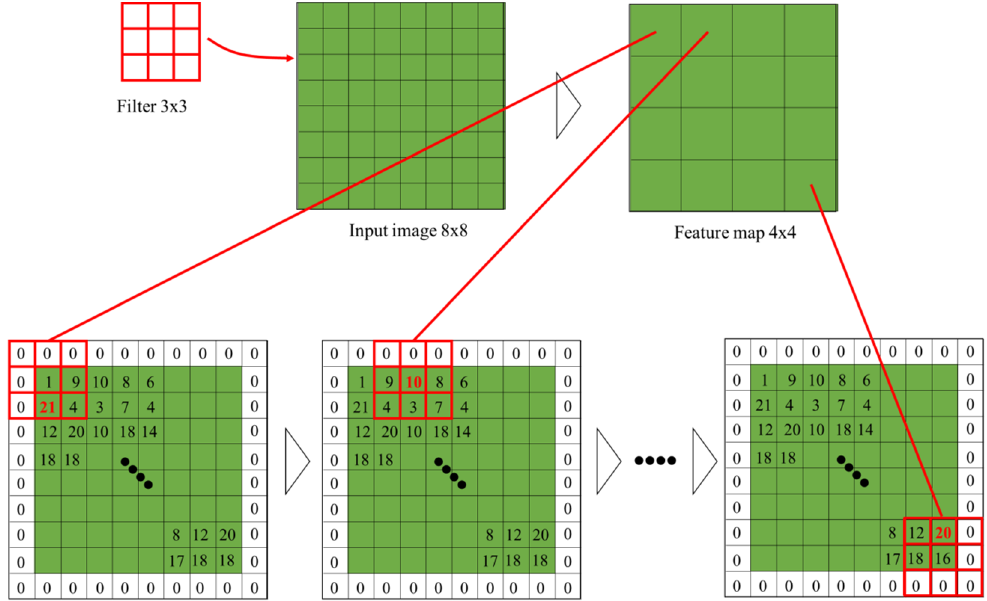
Figure A3. Sample image for 3 × 3 max pooling with stride two and zero padding. The value indicates an RBG image, and the chosen value from max pooling is highlighted in red.